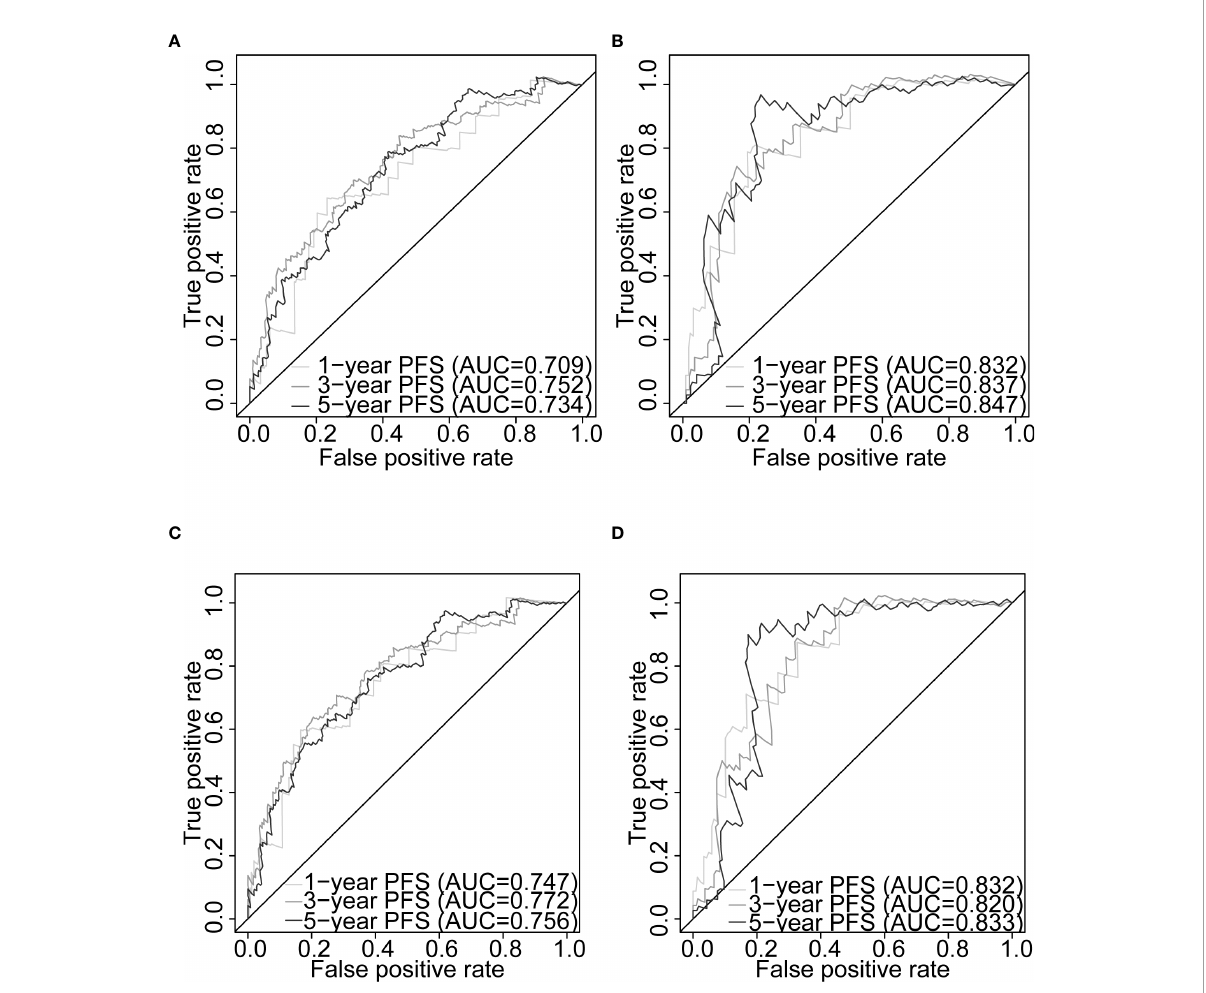
FIGURE 7 Nomogram evaluation of PFS in PCa patients. Time-dependent ROC curves assessing the nomogram model performance for 1-, 3-, and 5-year PFS, with the Gleason score classi fi ed into two subgroups ( ≤ 7 and >7) or fi ve subgroups (6, 7, 8, 9, and 10) in TCGA-PRAD training set ( A , C , respectively) and TCGA-PRAD testing set ( B , D , respectively). PCa, prostate cancer; PFS, progression-free survival; TCGA, The Cancer Genome Atlas; PRAD, prostate adenocarcinoma; ROC, receiver operating